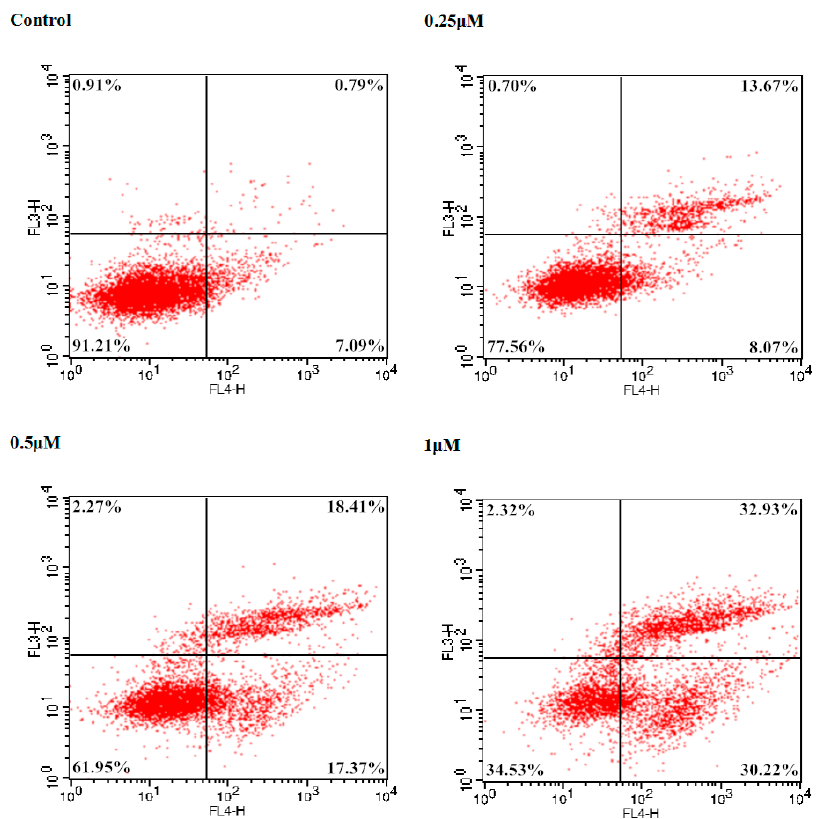
Figure 4. 9f induced mitochondrial depolarization in Bel-7402 cells.